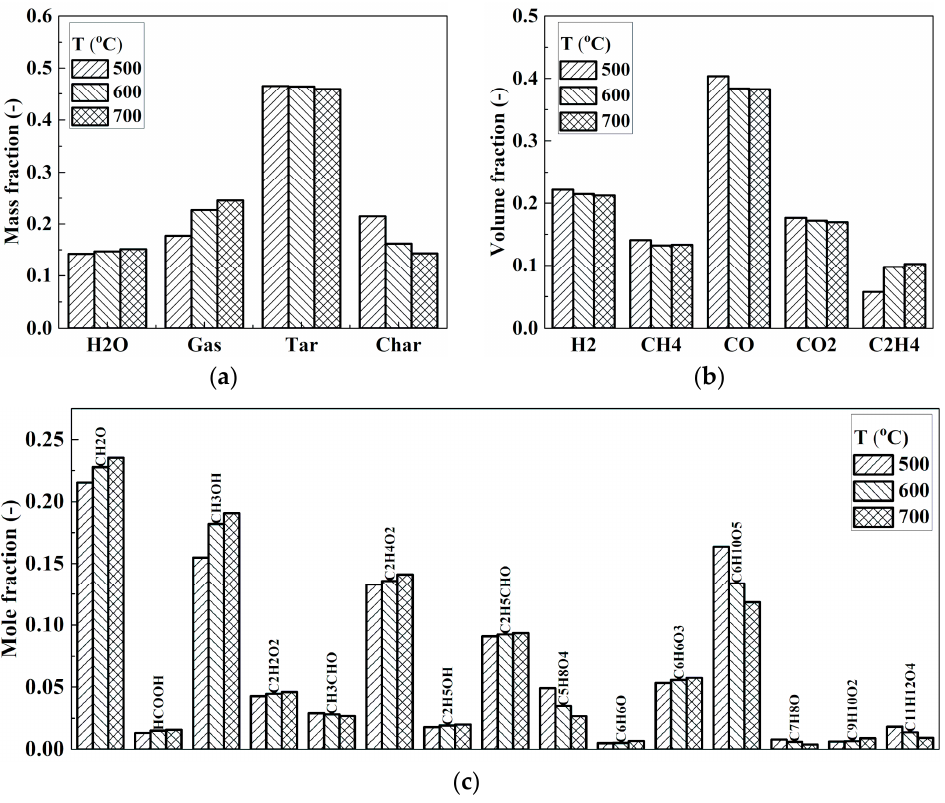
Figure 8. Pyrolysis products for different pyrolysis temperatures. ( a ) H 2 O, light gas, tar, and char; ( b ) light gas species; and ( c ) tar species.